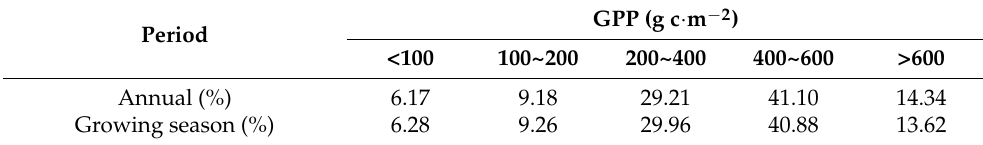
Table 1. Proportion of the area with a different GPP in annual and growing